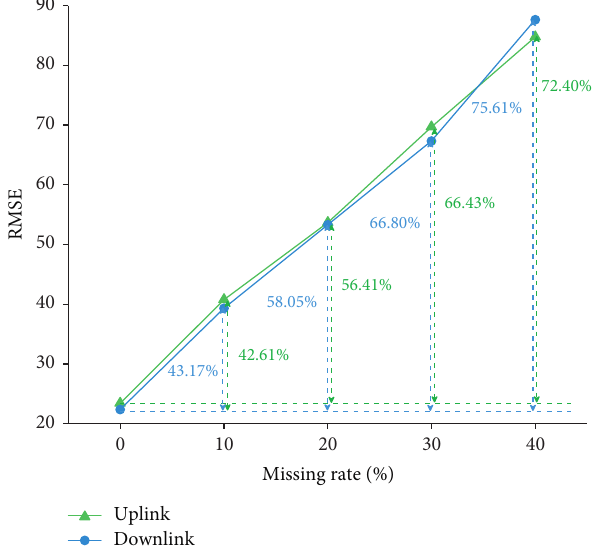
Figure 13: RMSE of up-direction and down-direction with dif- ferent missing